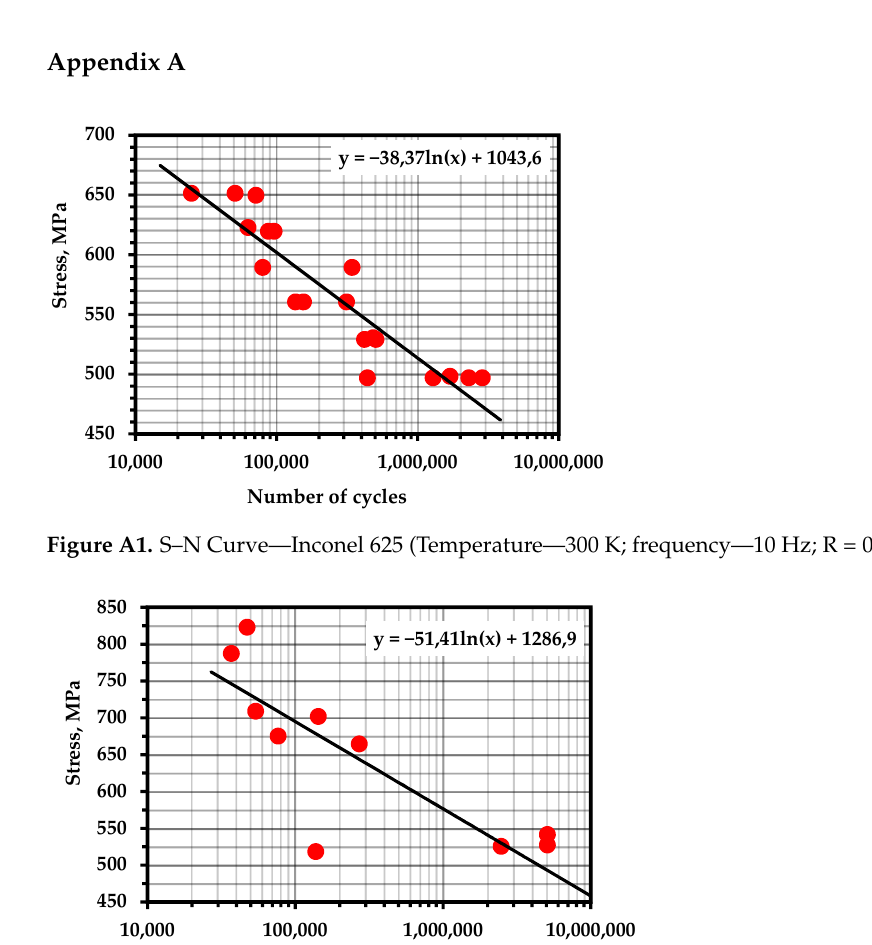
y = − 66,75ln(x) + 1307,2